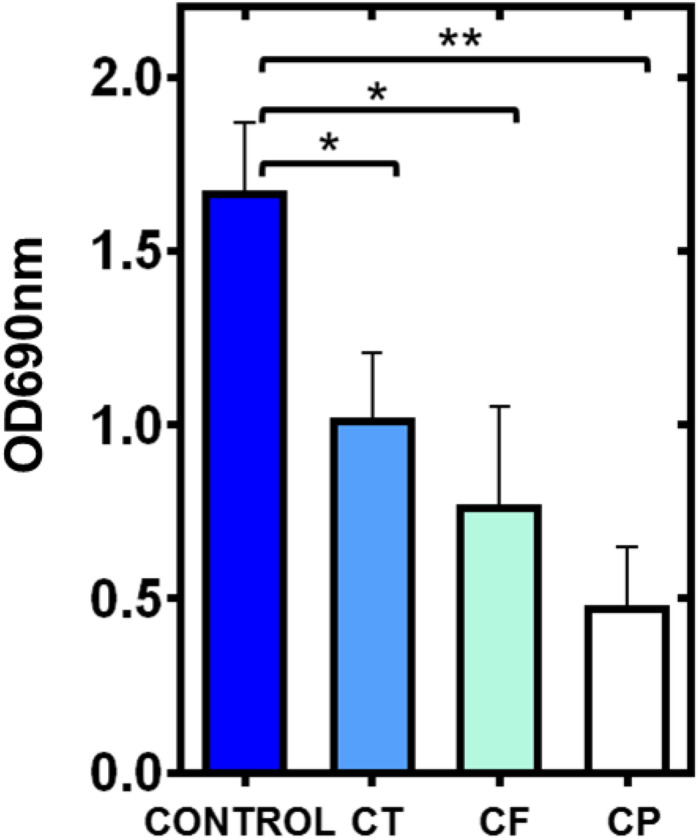
Inhibition of pyocyanin production of Pseudomonas aeruginosa PAO1 by cephalosporins. Graphical representation of OD690 nm showing the inhibition of blue color (pyocyanin production) by P. aeruginosa PAO1 in the presence of CT (CT), CF (CF), and CP (CP) (*p ≤ 0.05 and **p ≤ 0.01).